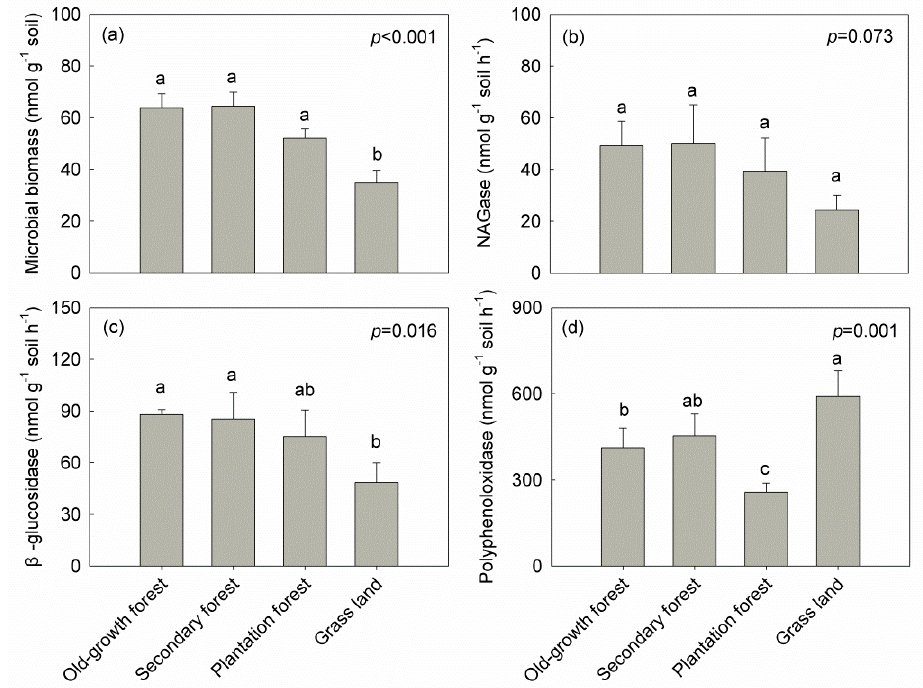
Figure 4. Soil total microbial biomass and microbial extracellular enzyme activities in different land-use types. Error bars represent the standard error of the mean. Different letters indicate statistically significant differences among the land-use types (Tukey HSD test, 5% level). NAGase: N-acetylglucosaminidase.